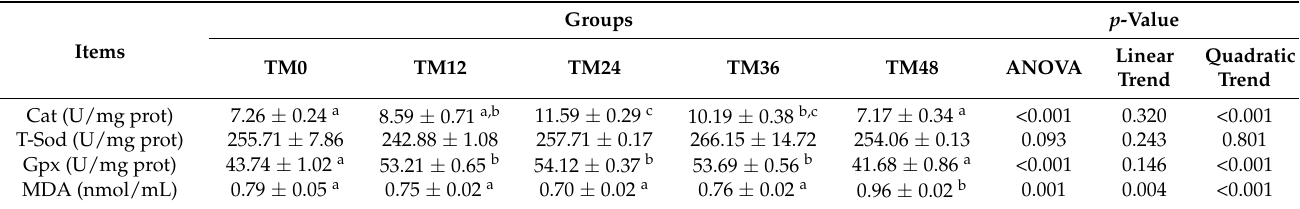
Table 8. Effects of fishmeal replacement with TM on hepatic antioxidant capacity and protein me- tabolism in Micropterus salmoides a .